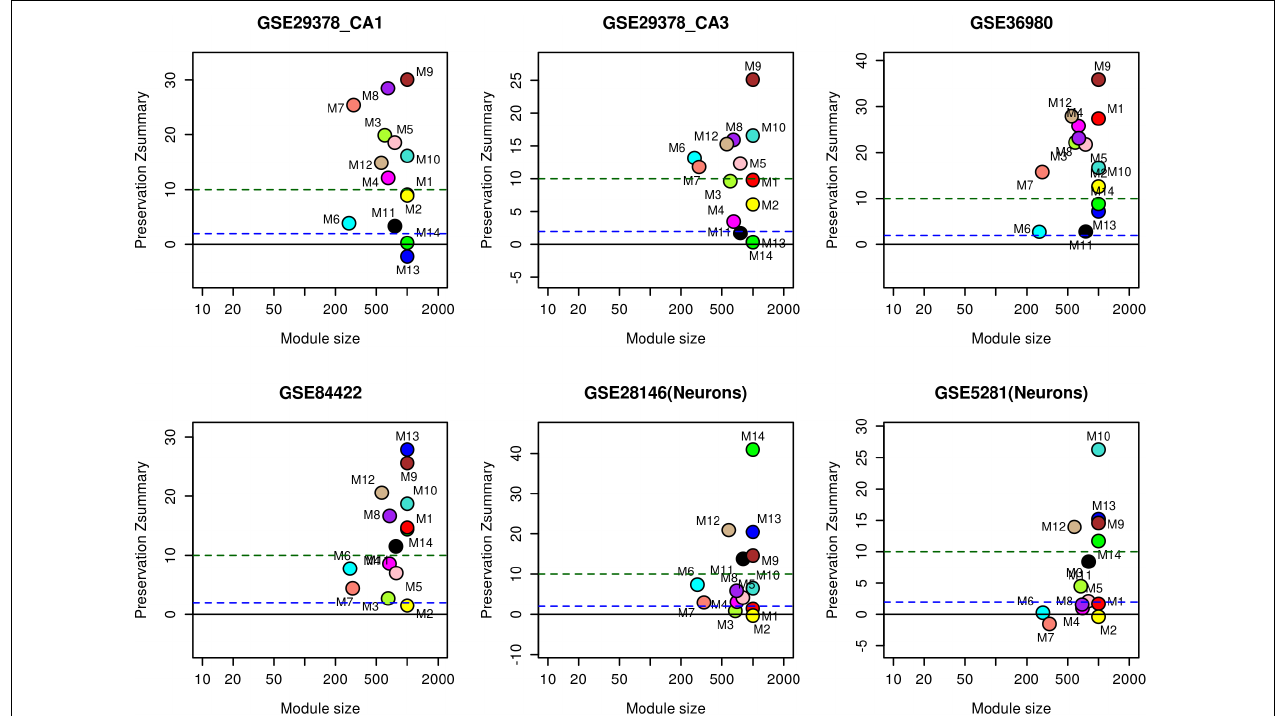
FIGURE 5 | Module preservation analysis with hippocampal